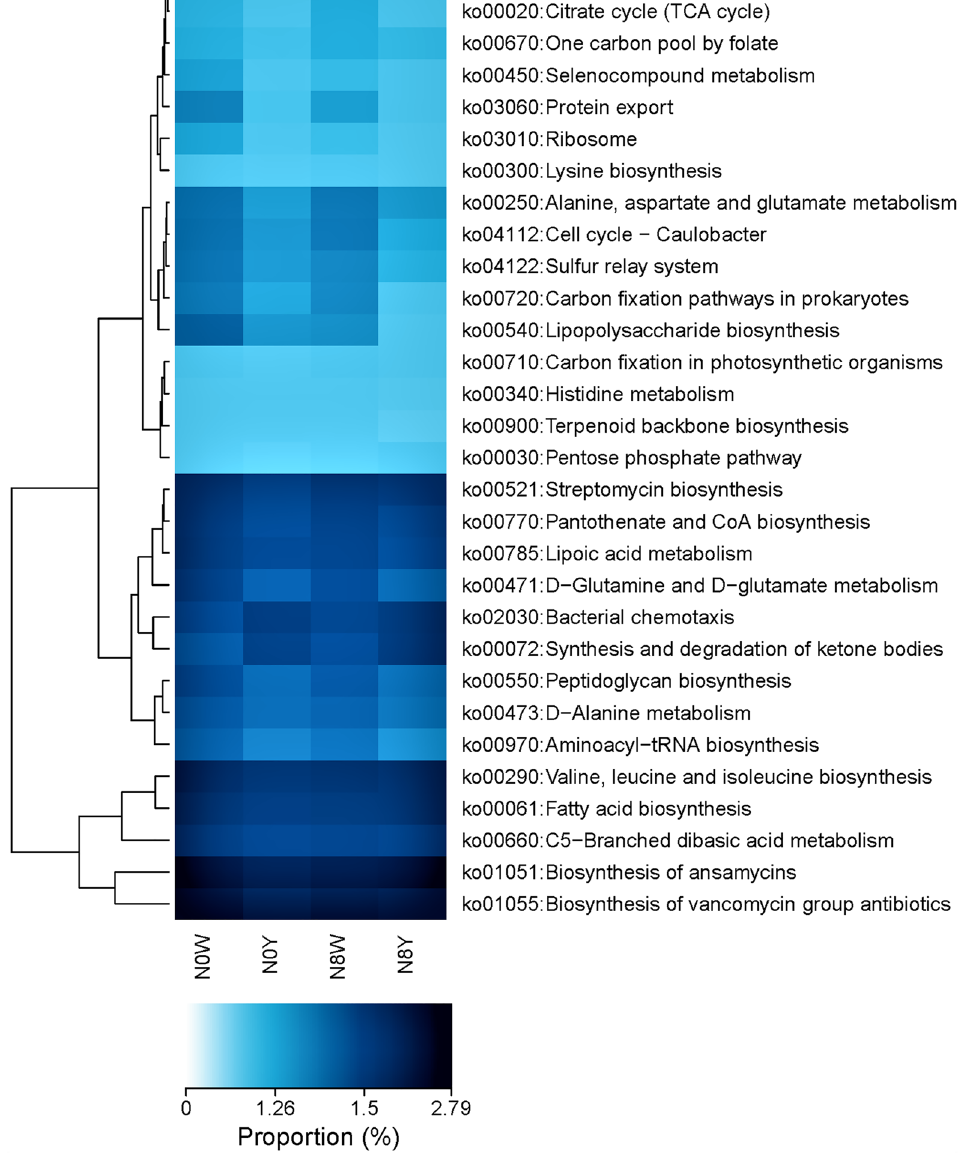
Figure 3. Analysis of microbially mediated KEGG metabolic pathways in sorghum inter-root soil under different nitrogen